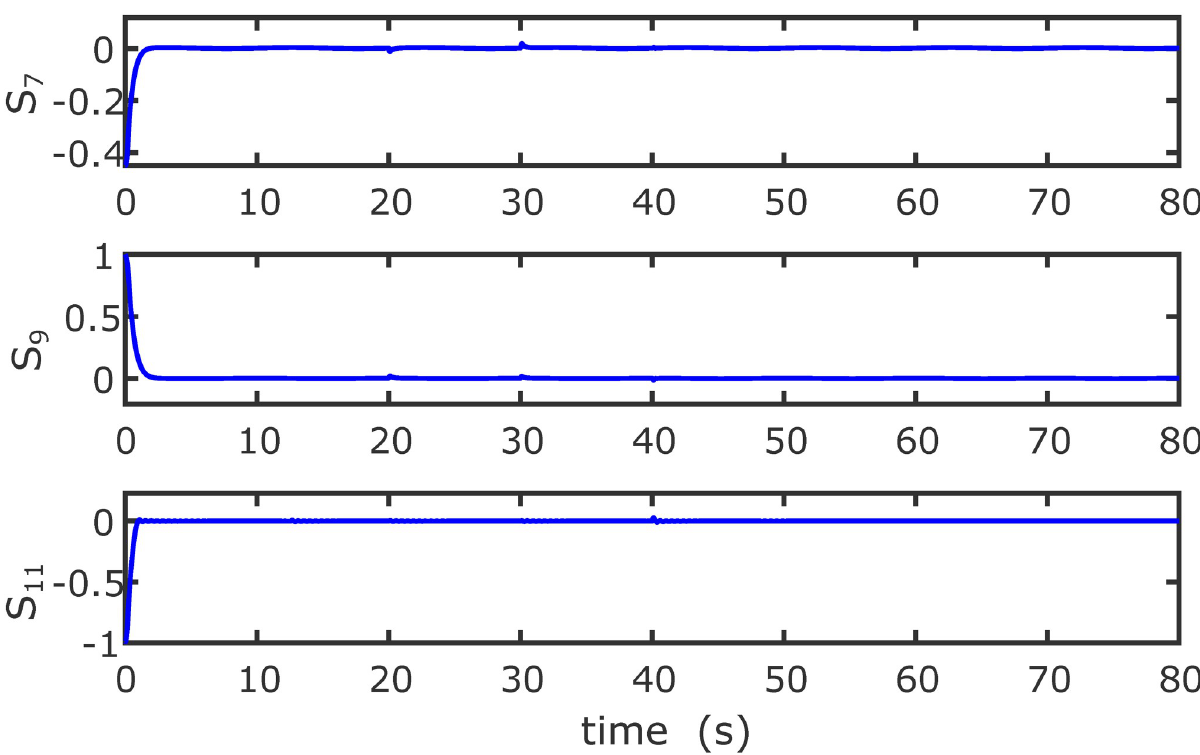
Fig 7. Results of the position sliding variables under the proposed controller.